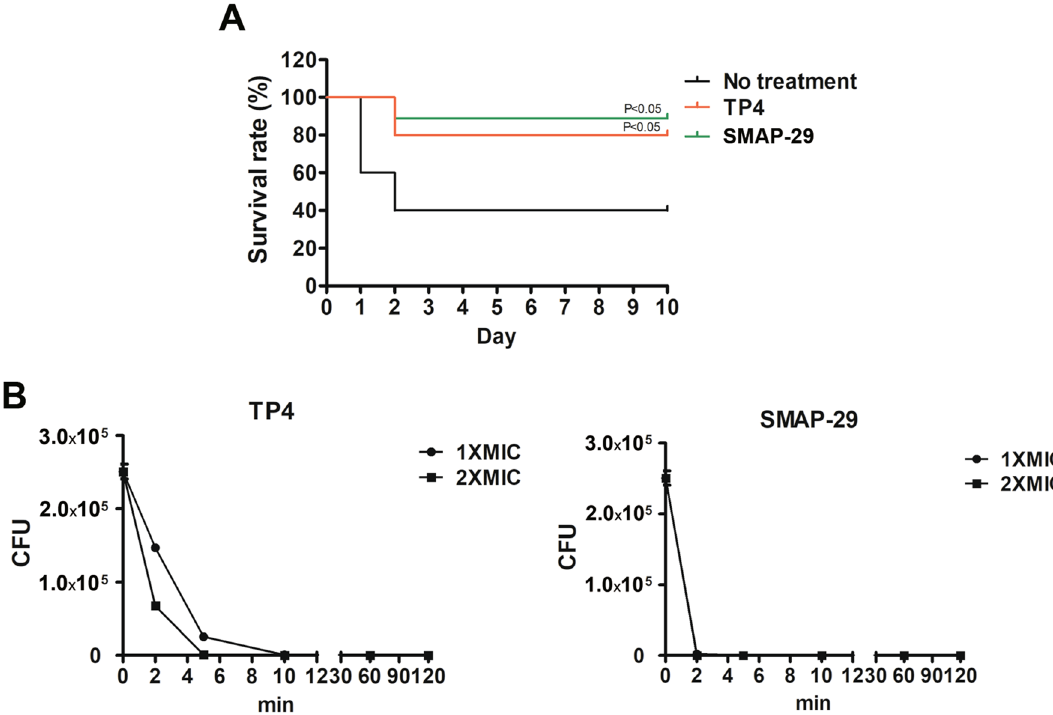
Figure 1. Prophylactic intratracheal administration of TP4 and SMAP-29 reduced mortality associated with A. baumannii -induced pneumonia. ( A ) Mice were intratracheally infected with A. baumannii ATCC 17,978 at a dose of 5 × 10 8 CFU. A 10-μL aliquot of 2 × MIC of TP4 (16 μg/mL) and SMAP-29 (32 μg/mL) was intratracheally administered 30 min before bacterial infection and mouse survival detected daily ( n = 10/group). ( B ) A. baumannii ATCC 17,978 (2–5 × 10 5 CFU) were mixed with 1 × and 2 × MIC of TP4 (8 and 16 μg/mL) or SMAP-29 (16 and 32 μg/mL) and incubated at 37 °C. The survival bacteria were detected by plating on agar